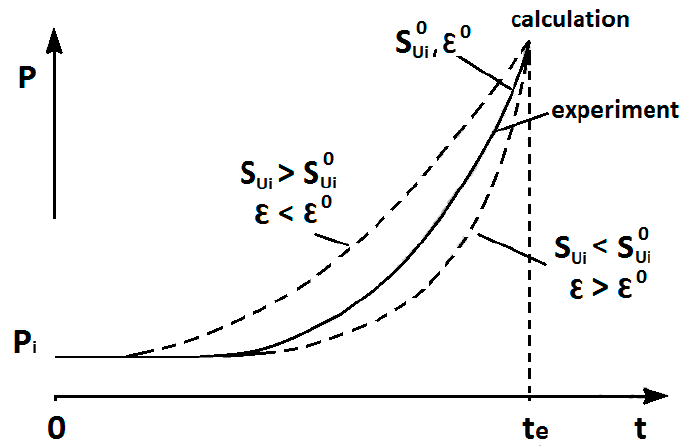
Figure 1. The effect of initial laminar burning velocity, S ui and thermokinetic index, ε on the deflagration pressure transient.